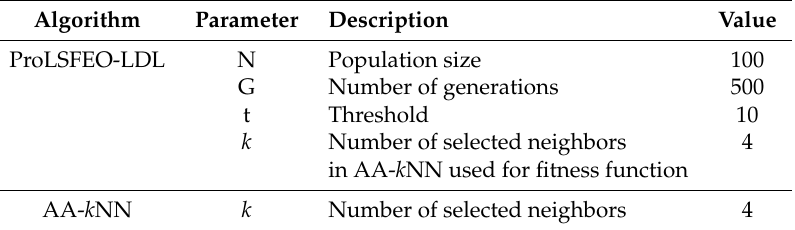
Table 3. Summary of the